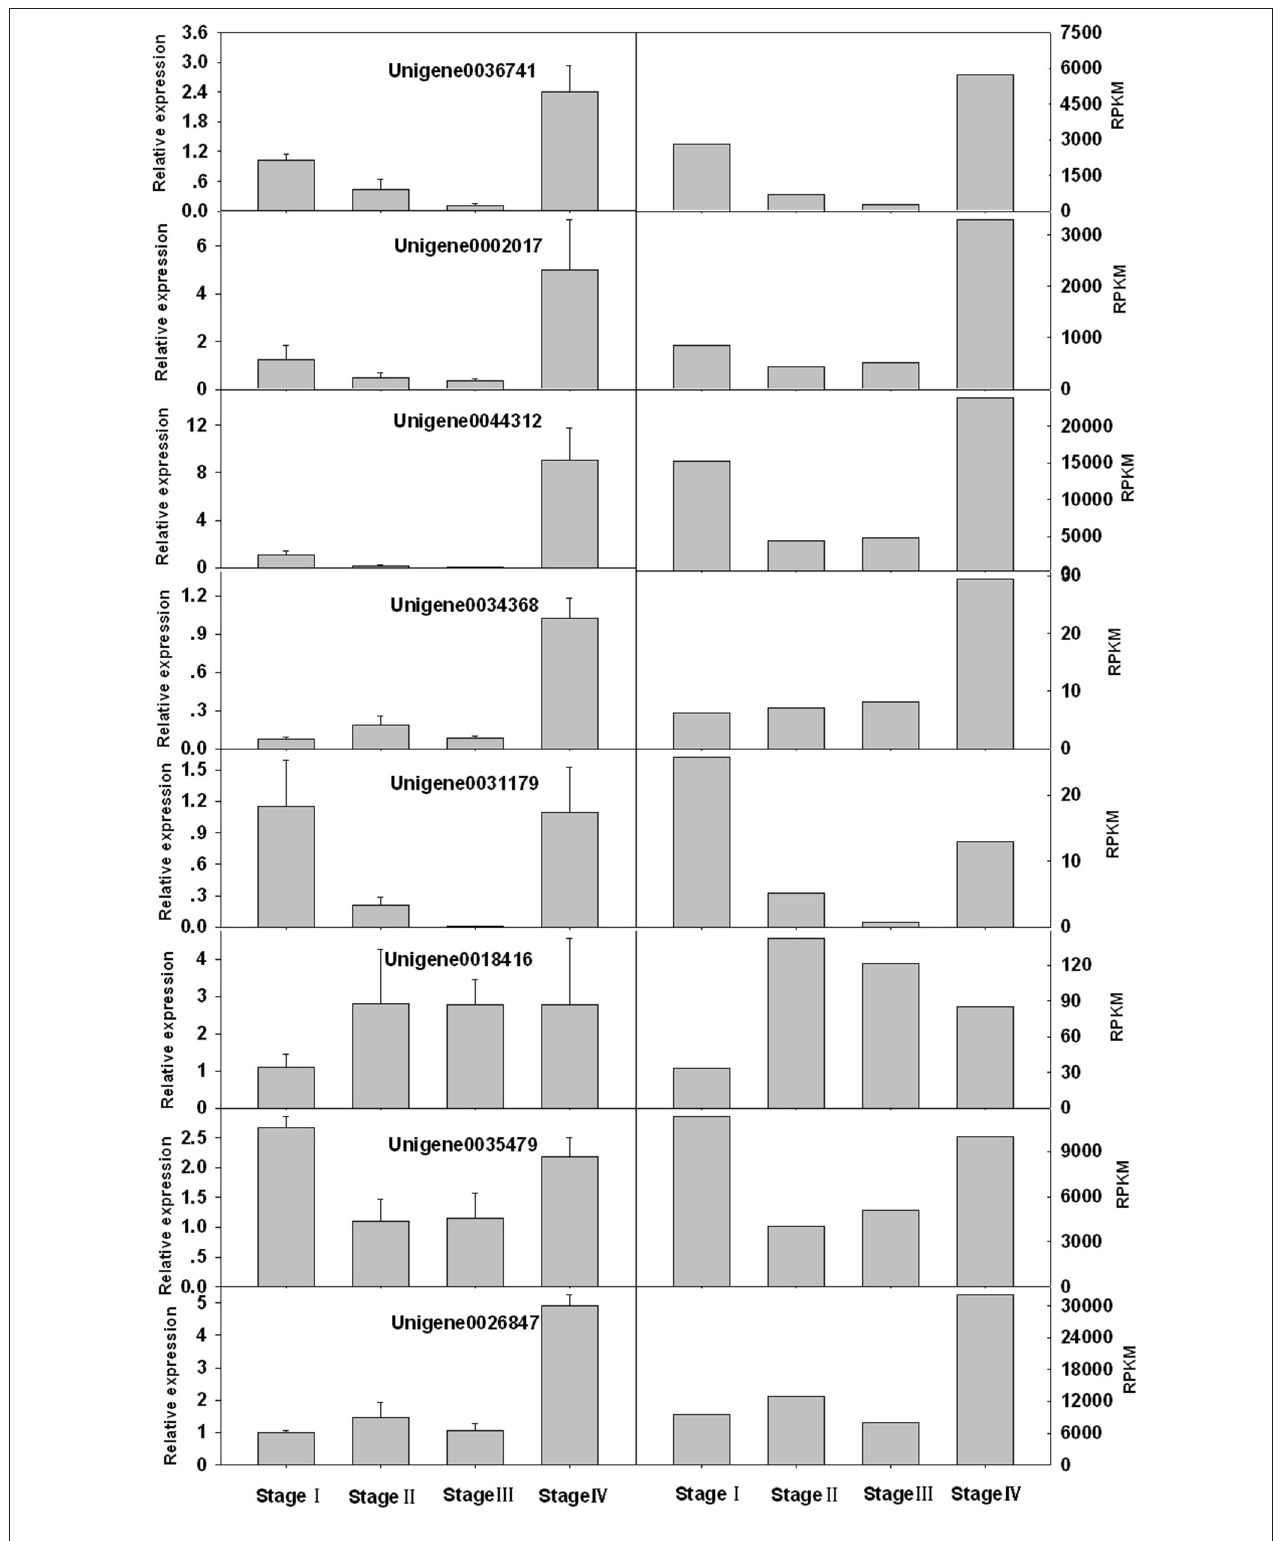
FIGURE 8 | Comparison of expression levels of 8 genes obtained by qPCR analysis (left) and by RNA-seq (RPKM values) (right).